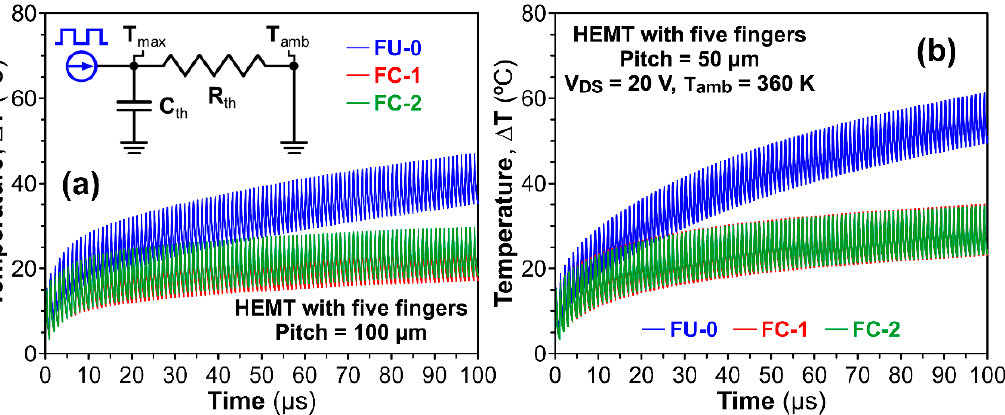
Figure 5. Transient temperature responses of three different bonding schemes. The GaN HEMTs with five gate fingers operated at a pulse-width modulation frequency of 1 MHz with a duty cycle of 25% for the gate pitch of ( a ) 100 µm and ( b ) 50 µm, respectively. The V DS and T amb are fixed at 20 V and 360 K. The inset of Figure ( a ) shows the effective thermal RC network model.